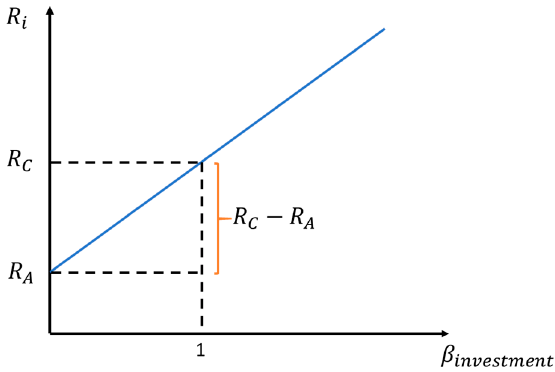
Figure A6. Positive relationship between expected return and investment growth premium.